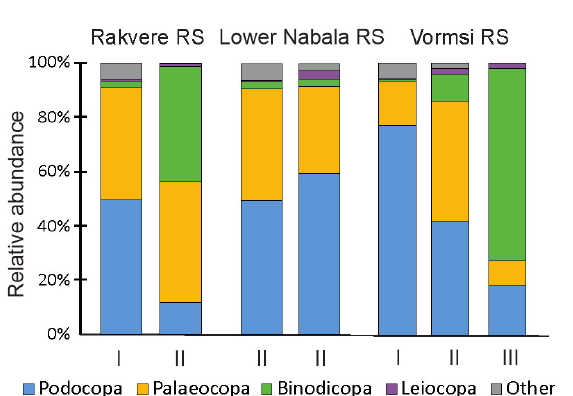
Fig. 8. Taxonomic distribution of ostracods in the analysed formations of the Rakvere, lower Nabala and Vormsi regional